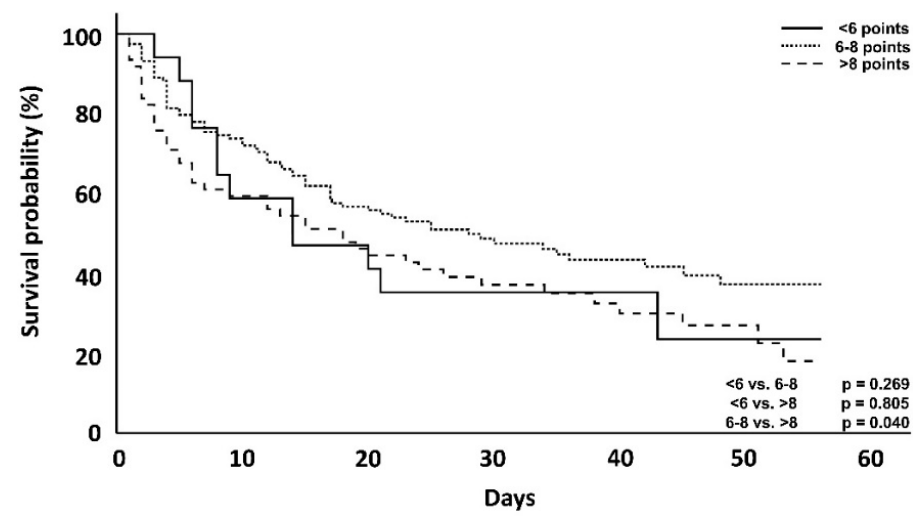
Figure 4. Kaplan–Meyer survival analysis at day 56 of CytoSorb treated patients. The p -value is via log-rank test. * = Statistically significant using Bonferroni-adjusted alpha critical value = 0.017 (no such cases).